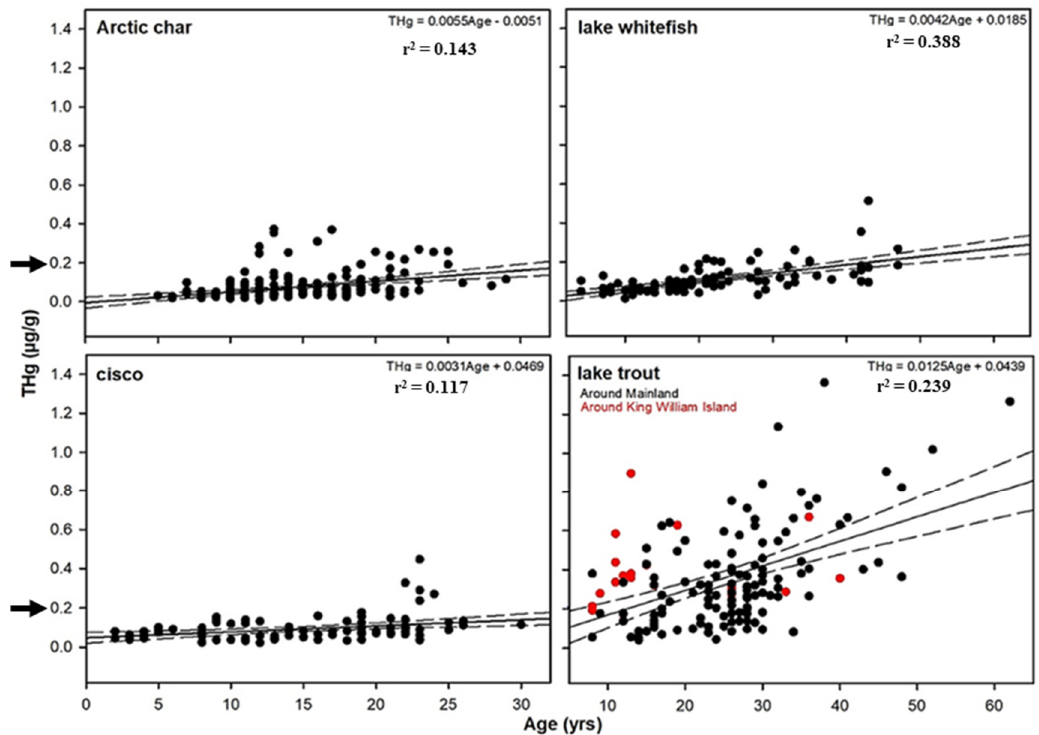
Figure 4. Relationship between total mercury (THg; µg·g − 1 ) and age (years, determined by otolith analysis; note the different scale for ages of Arctic char and cisco vs. lake whitefish and lake trout) with regression lines and with dots indicating individual fish samples, albeit with many overlapping dots. The recommended level for THg concentrations in fish for subsistence fisheries from several jurisdictions (see Results and Discussion Section) is approximately 0.2 µg·g − 1 (shown as black arrows on the labeled axes). For lake trout, THg levels in fish caught on King William Island are shown as red dots, with all of these falling at or above the 0.2 µg·g − 1 level. Further analysis showed that these were not statistically lower than comparable fish obtained from the mainland, which are shown as black dots (see Results and Discussion Section). The regression line represents lake trout from the mainland with the corresponding r 2 noted, with the island (red dots) regression line not shown with r 2 = 0.324, and for all total lake trout assayed as indicated in Table